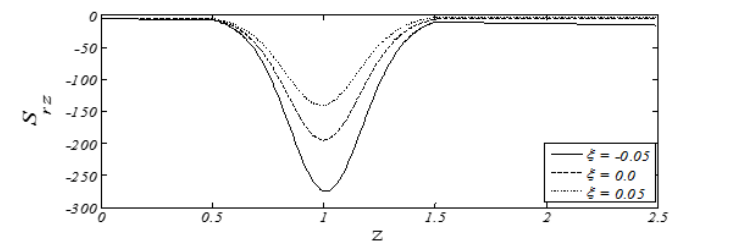
Fig. 10 Wall shear stress variation for F=1, L=1, a=0.2, b=0.4, δ =0.4.